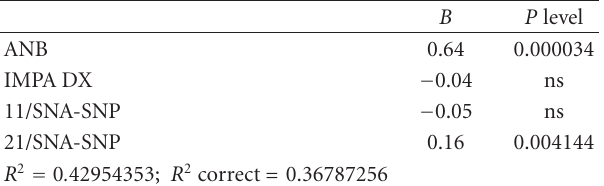
Table 3: Entire sample (42 subjects): linear regression results for Table 7: Group 2 (17 subjects): linear regression results for OJ- OJ-r; only ANB and 21/SNA-SNP were found to be statistically r: only the ANB variable was found to be statistically significant. significant. The systematic error calculated via Student’s t -test for The systematic error calculated via Student’s t -test for paired data paired data yielded a significance level of 0.05; ns: nonsignificant. yielded a significance level of 0.05; ns: non significant (Student’s t - test). B P level